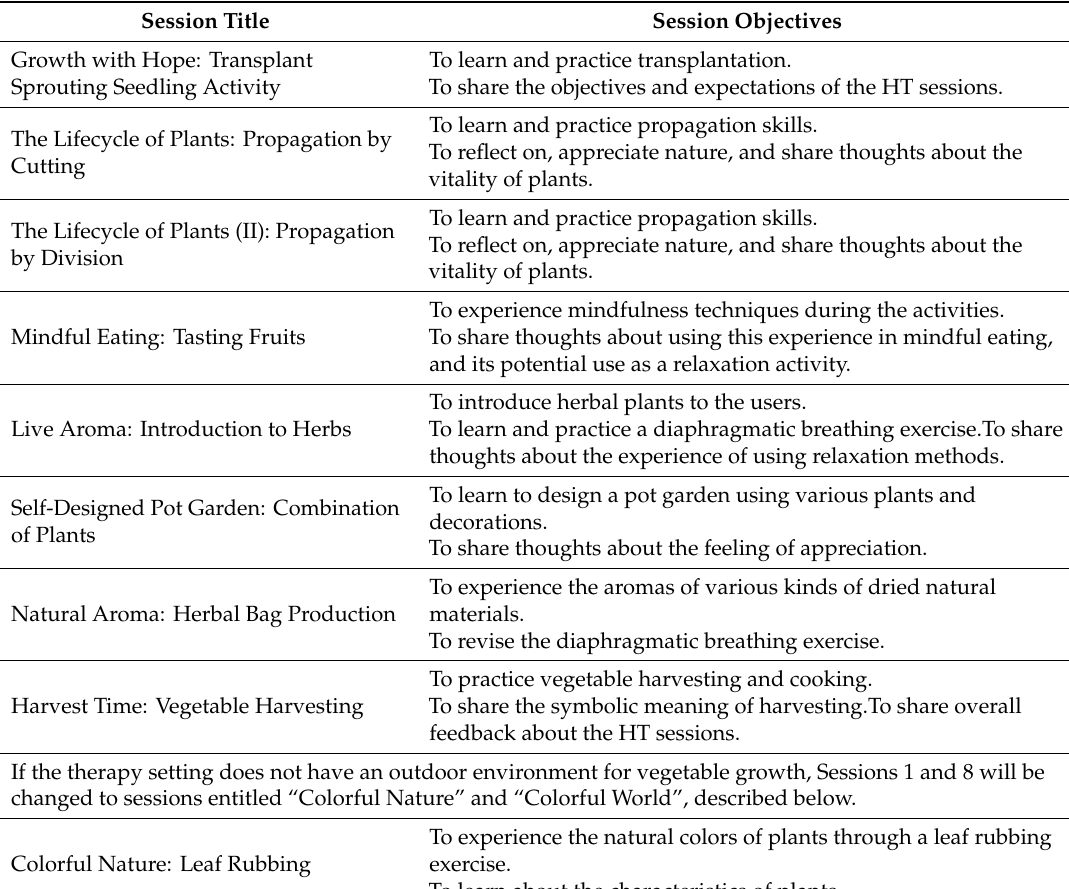
Table 1. Session titles and objectives of the horticulture therapy (HT)